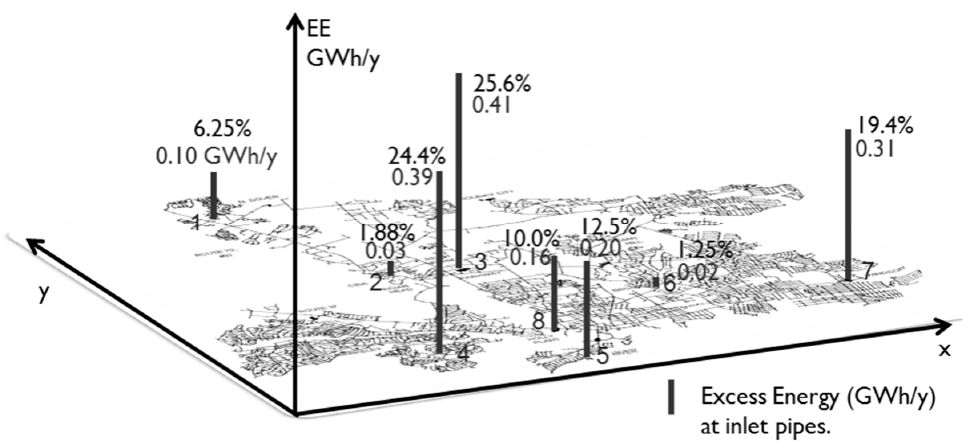
Figure 5. Excess energy input distribution.